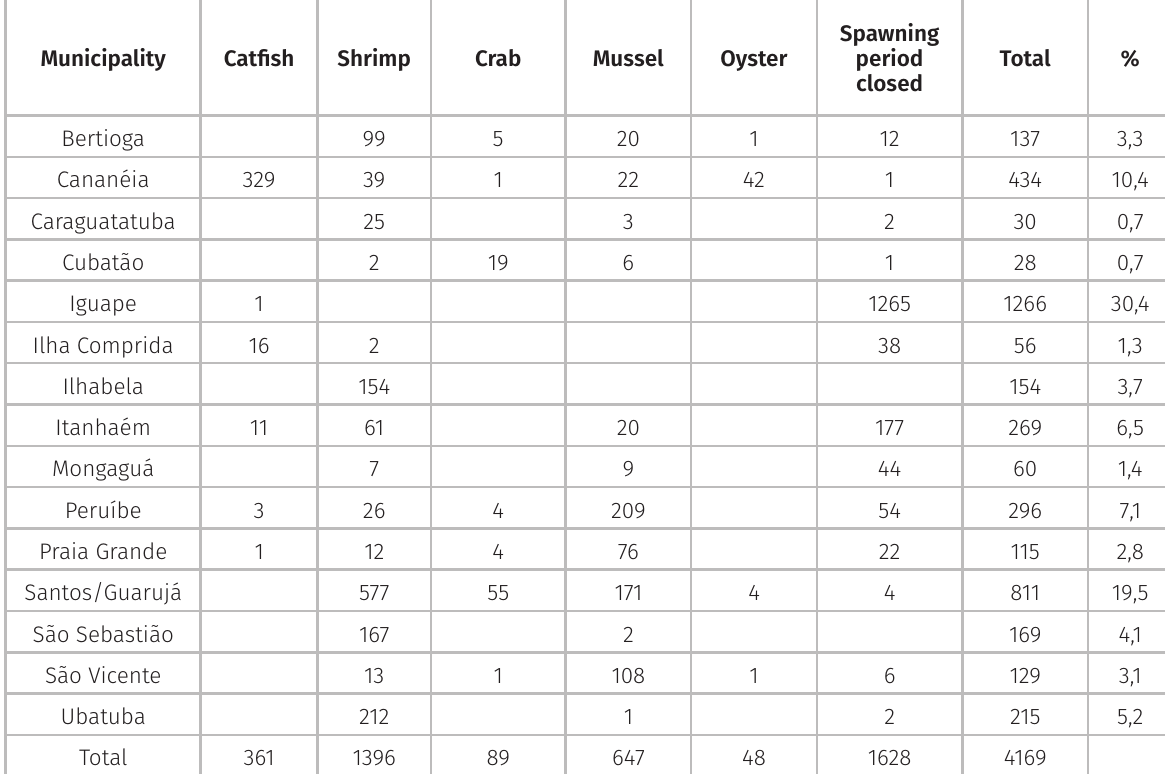
Table I. Total number of anglers insured according to the product of the closure on the coast of São Paulo in 2014.